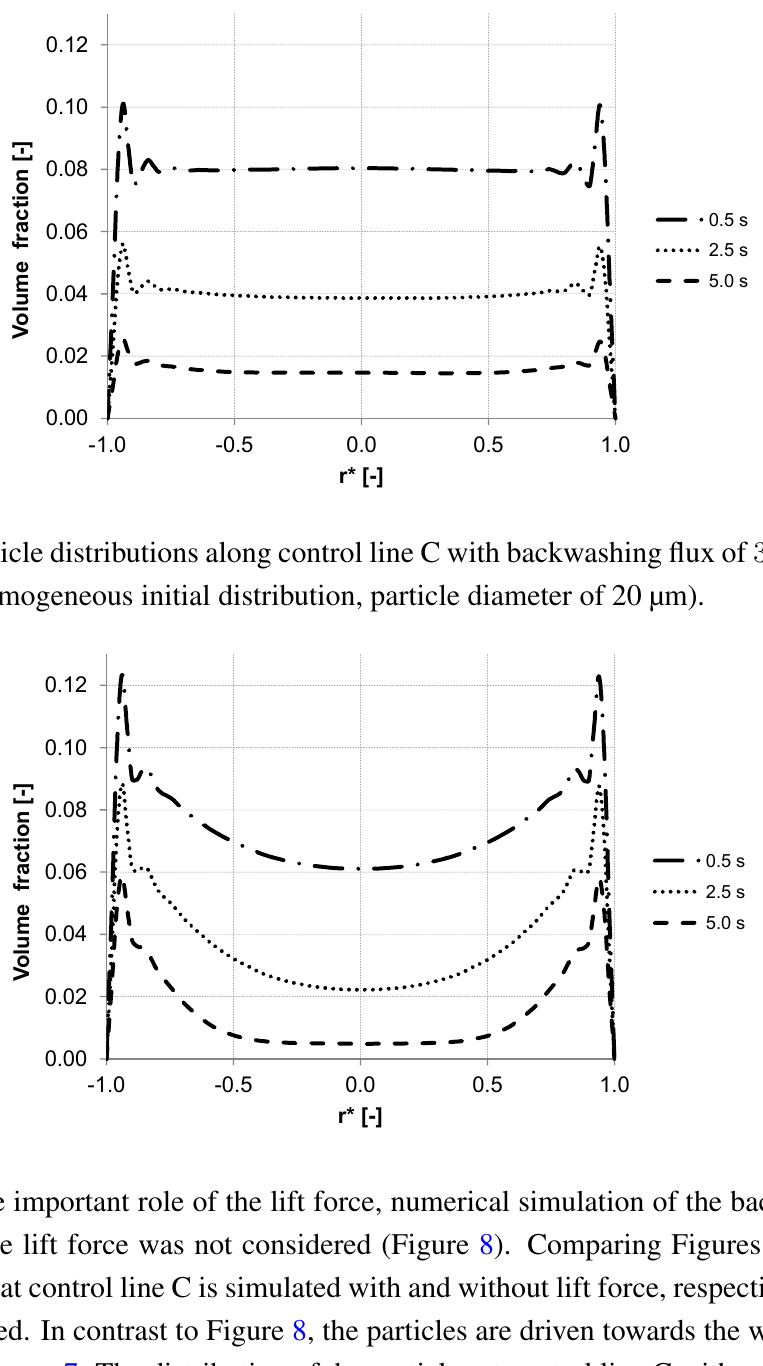
Figure 6. Particle distributions along control line B with backwashing flux of 300 L m − 2 h − 1 during 5 s (homogeneous initial distribution, particle diameter of 20 µm).